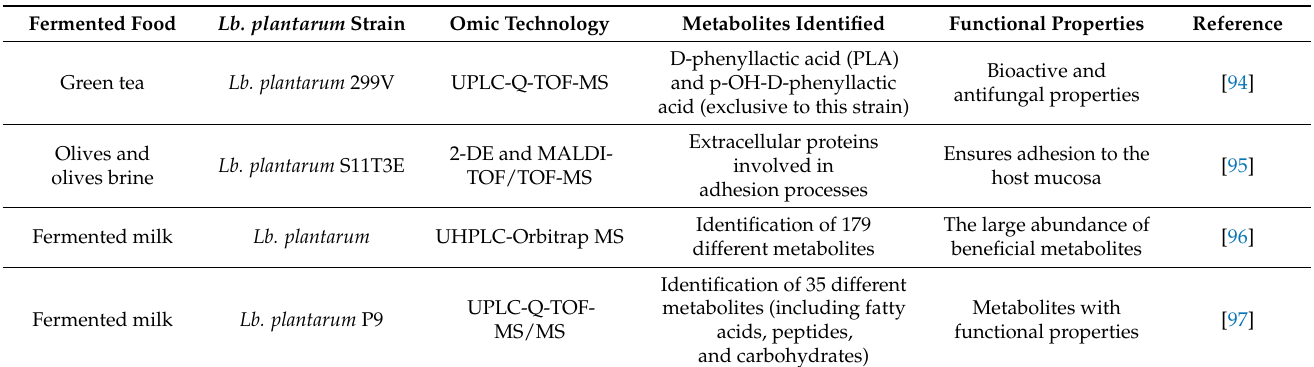
Table 2. Application of omics technologies in the study of some functional fermented foods using Lb.